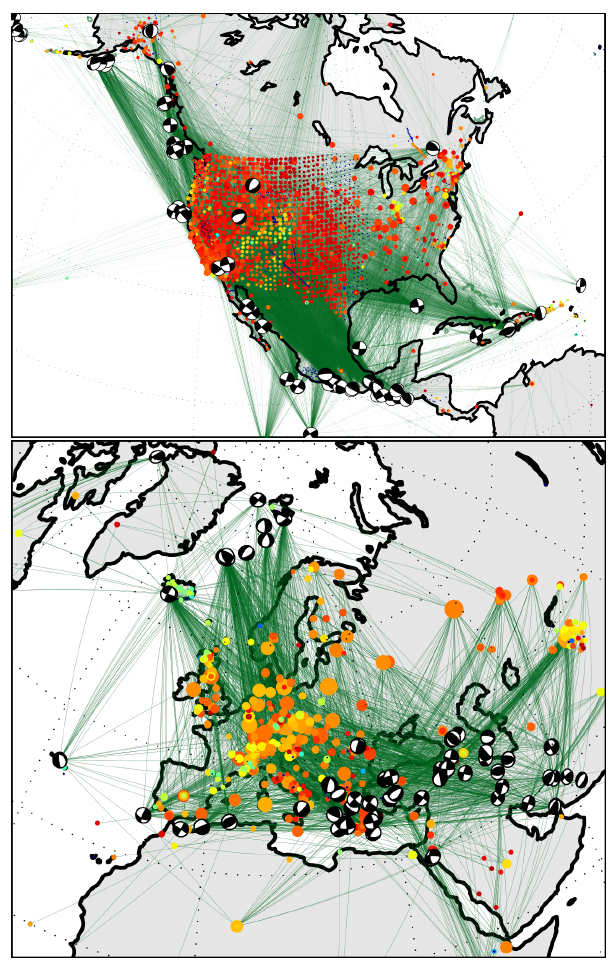
Fig. 7. Source and stations in two regional data sets for North America and Europe. The rays connect source-receiver combinations at distances between 15 and 35 degrees. Earthquake locations are shown as beachballs. Station colour codes for the goodness of fit between to observed and modelled waveforms at each station. Red denotes median cross-correlation coefficient of CC max > 0 . 8, which we consider a reasonable threshold for accepting any individual measurement. Orange and yellow colours indicate a lower median fit, which means that only some waveforms at this station may be used. Marker size is proportional to the number of events recorded by the station.